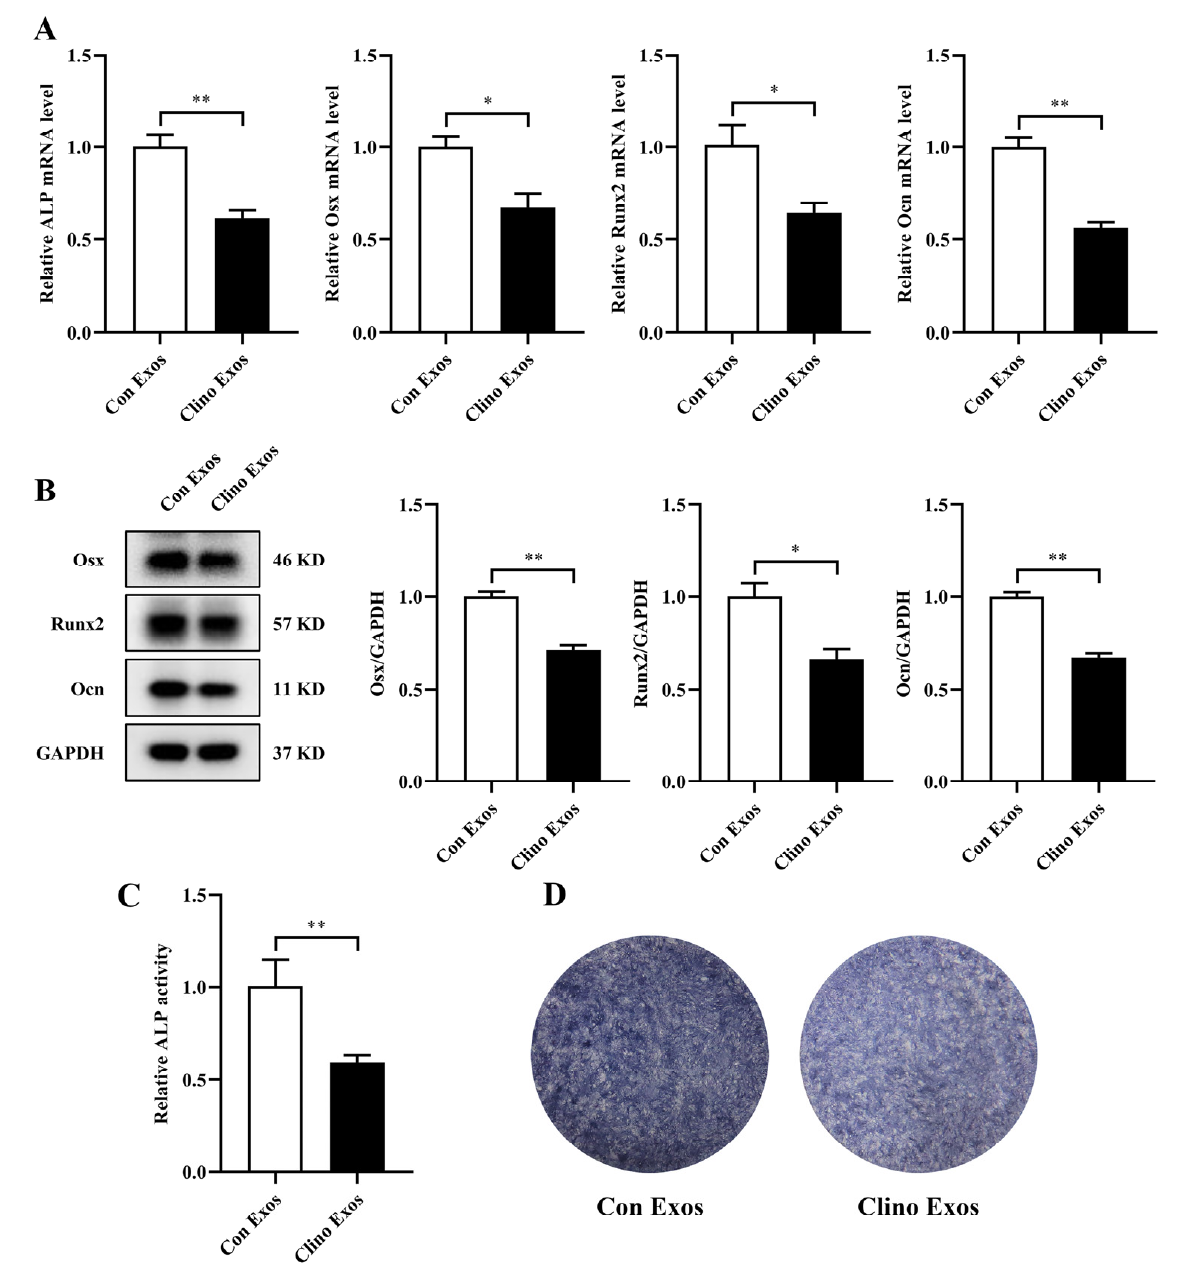
Figure 2. Exosomes derived from MVECs cultured under mechanical unloading attenuate osteoblast differentiation. ( A ) qRT–PCR analysis of ALP, Osx, Runx2, and Ocn in MC3T3-E1 cells treated with Con Exos/Clino Exos (200 µ g/mL) ( n = 3). ( B ) Western blotting analysis of Osx, Runx2, and Ocn in MC3T3-E1 cells treated with Con Exos/Clino Exos ( n = 3). ( C ) Relative ALP activity analysis of osteoblasts treated with Con Exos/Clino Exos ( n = 3). ( D ) Representative images of ALP staining in MC3T3-E1 cells treated with Con Exos/Clino Exos after osteoinduction for 7 days ( n = 3). * p < 0.05, ** p < 0.01 vs. control.